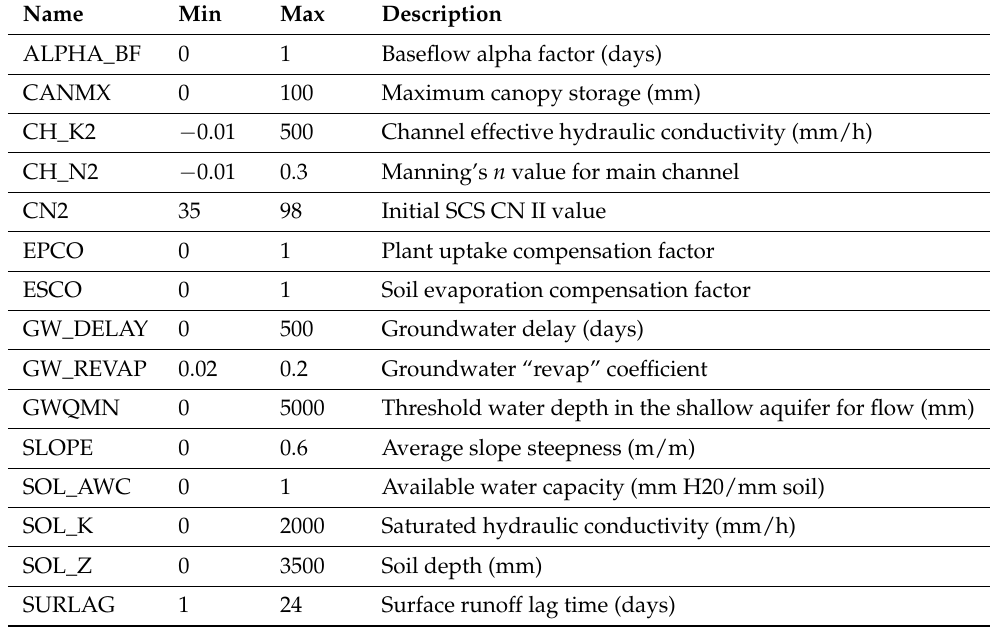
Table A1. The streamflow parameters and their range used in the SWAT model calibration